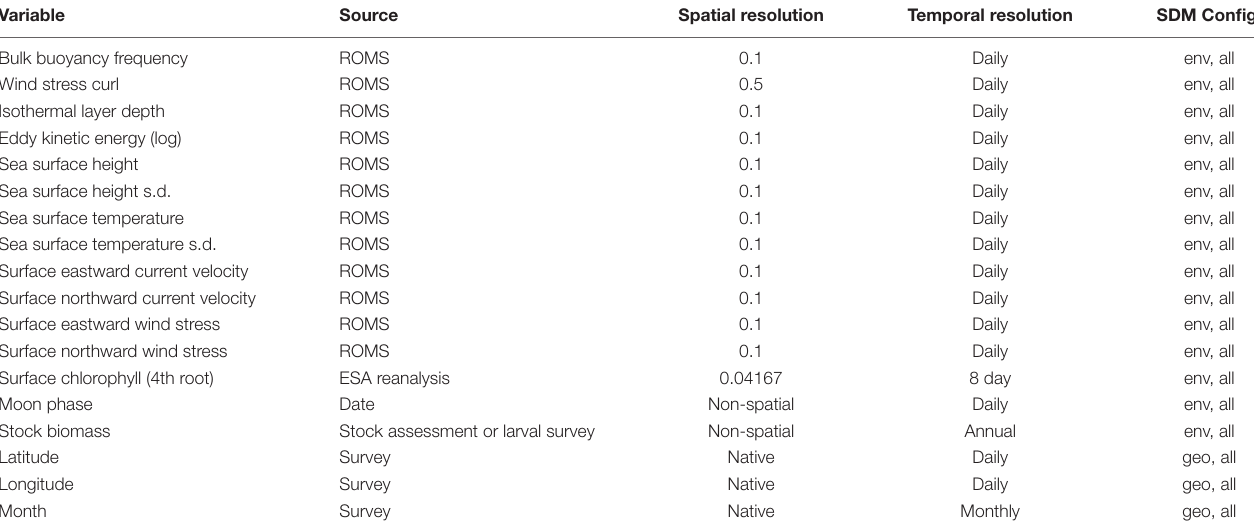
TABLE 1 | Predictors used to build SDMs, and SDM configurations which included each variable.